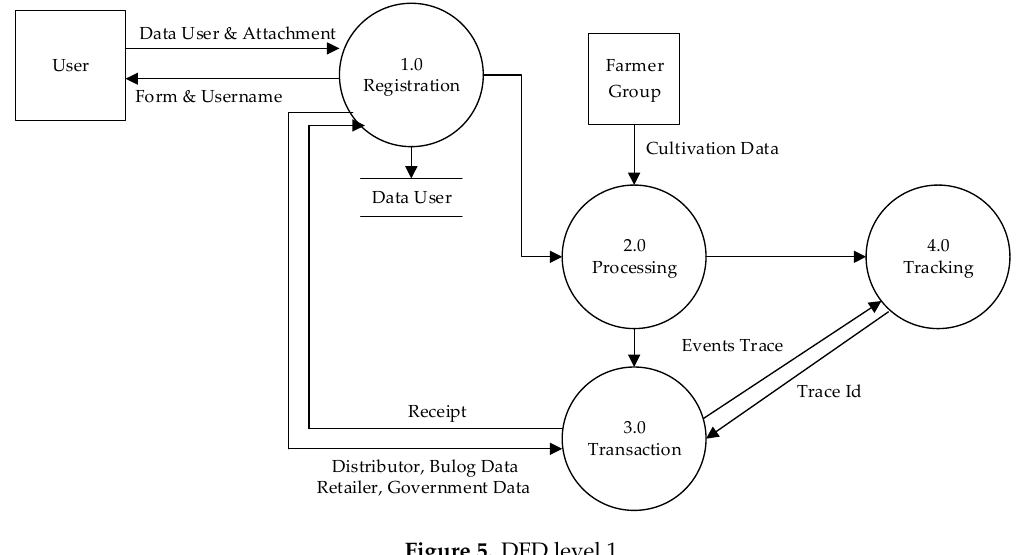
Figure 5. DFD level 1.